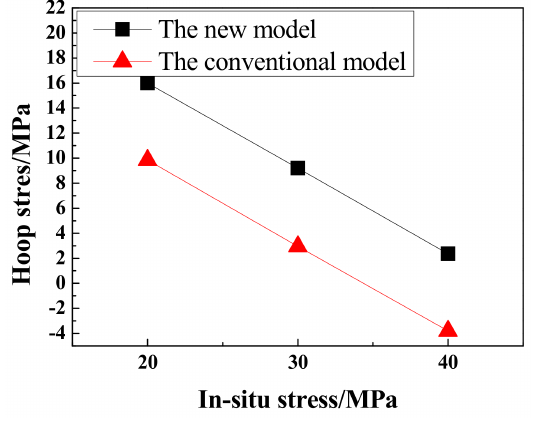
Figure 9. Hoop stress of cement sheath vs. in-situ stress.